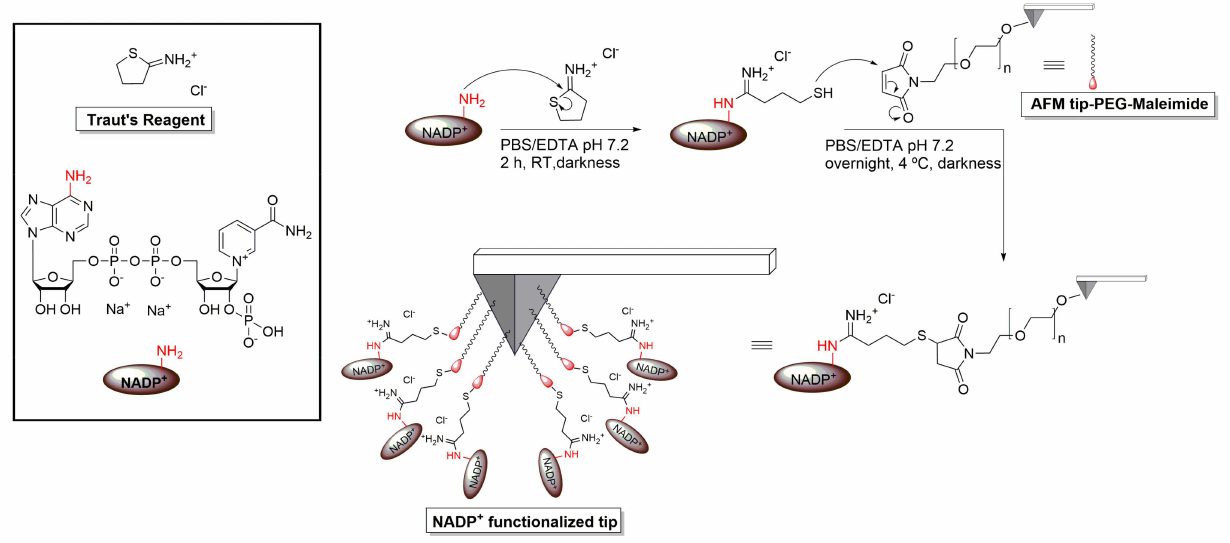
Figure 3. Procedure designed for the covalent attachment of NADP + to AFM tips. 2-Iminothiolane reacted with the primary amine of the adenine in NADP + molecules, creating amidine derivatives with reactive sulfhydryl groups. These were made to react with maleimide-PEG prefunctionalized AFM tips, producing the thiosuccinimide derivatives.